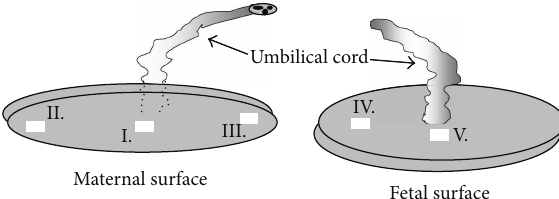
Figure 1: Location of samples collected in standardized manner from the maternal surface of the placenta (I–III) and from the fetal surface (IV-V). The mean weight of the sample: 10.49 ± 0.89